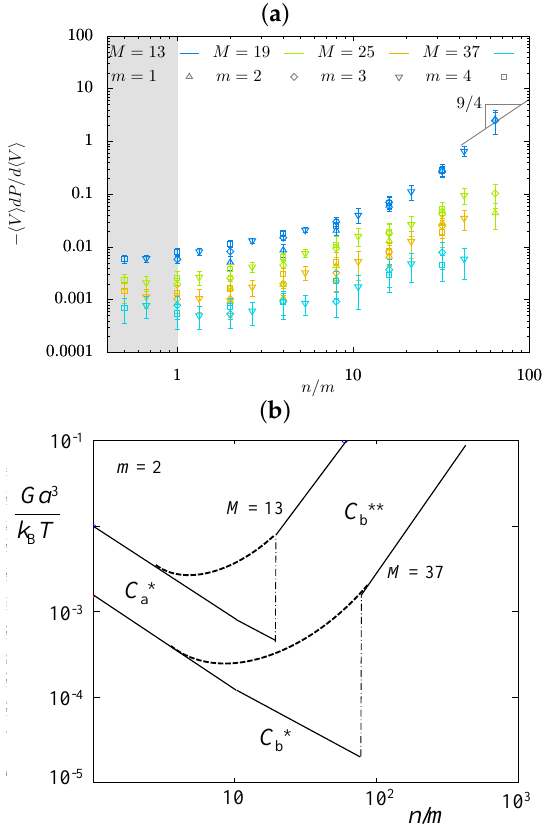
Figure 9. Osmotic modulus G as a function of n / m in MC simulations ( a ) and scaling model ( b ). A conjecture that sharp minimum could be smoothed in simulations is illustrated by the dashed lines ( b